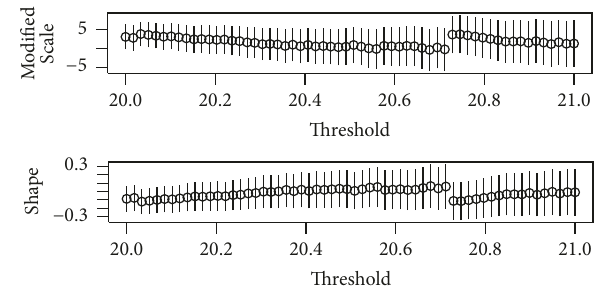
Figure 4: Figure of calibration scale parameters and scale parame- ters of losses.